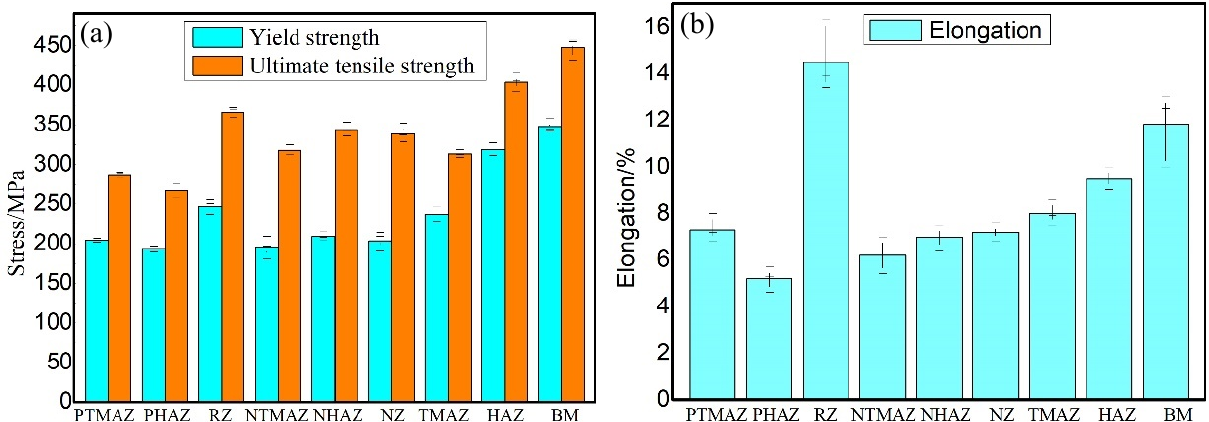
Figure 16. Tensile properties of different zones of the joints: ( a ) YS and UTS and ( b ) elongation.